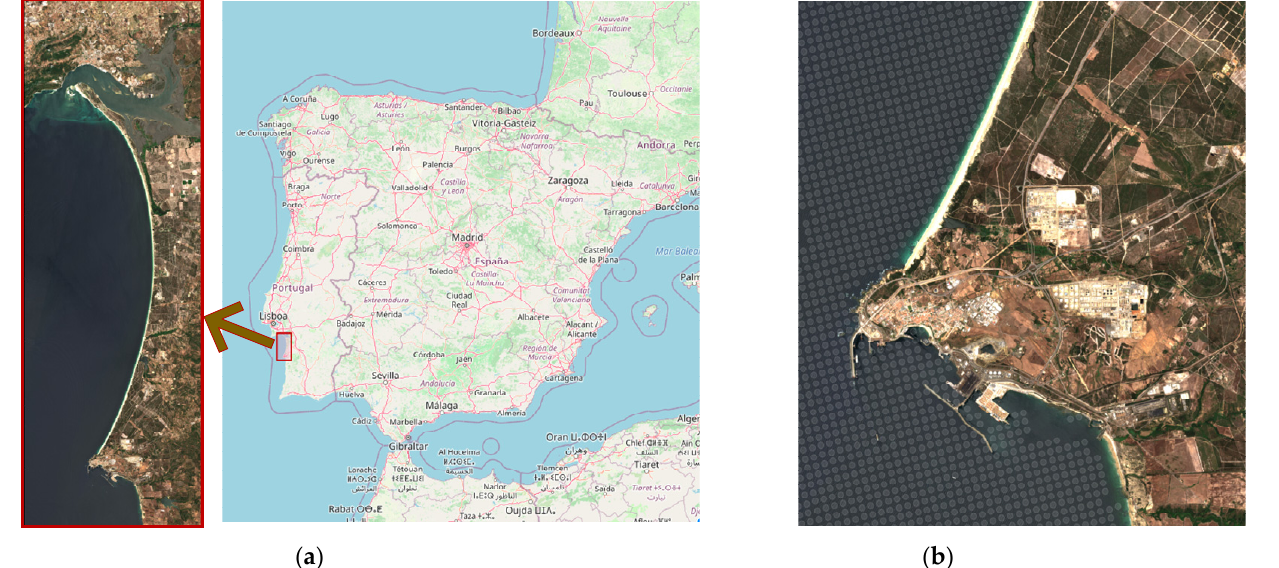
Figure 12. ( a ) Case study; Sines, Portugal; ( b ) potential WEC installation points of interest.